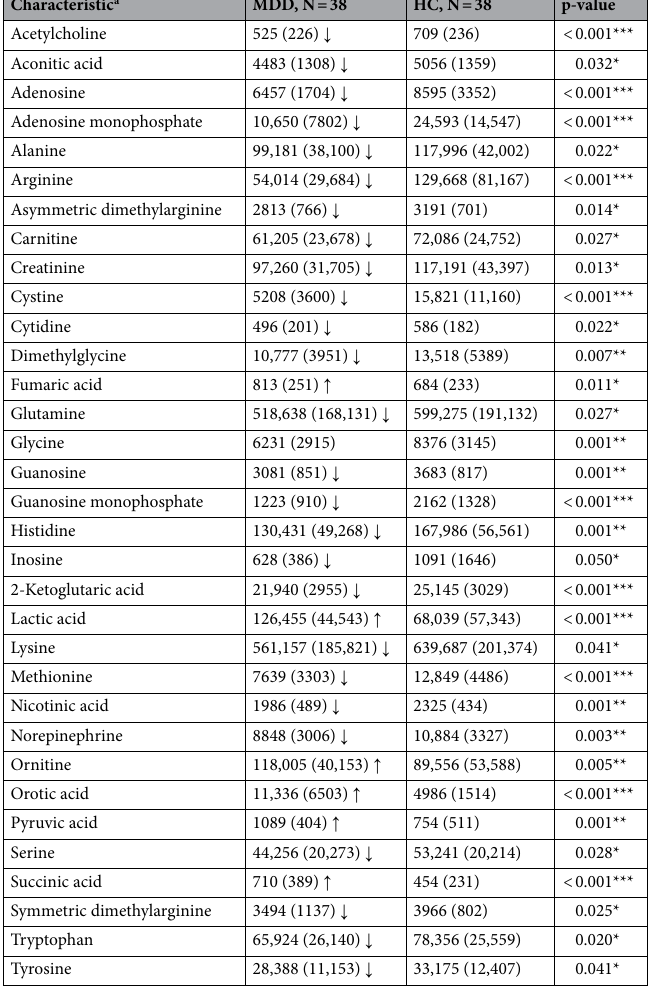
Table 4. Significantly different blood biomarkers in MDD and HC. a Statistics presented: mean of